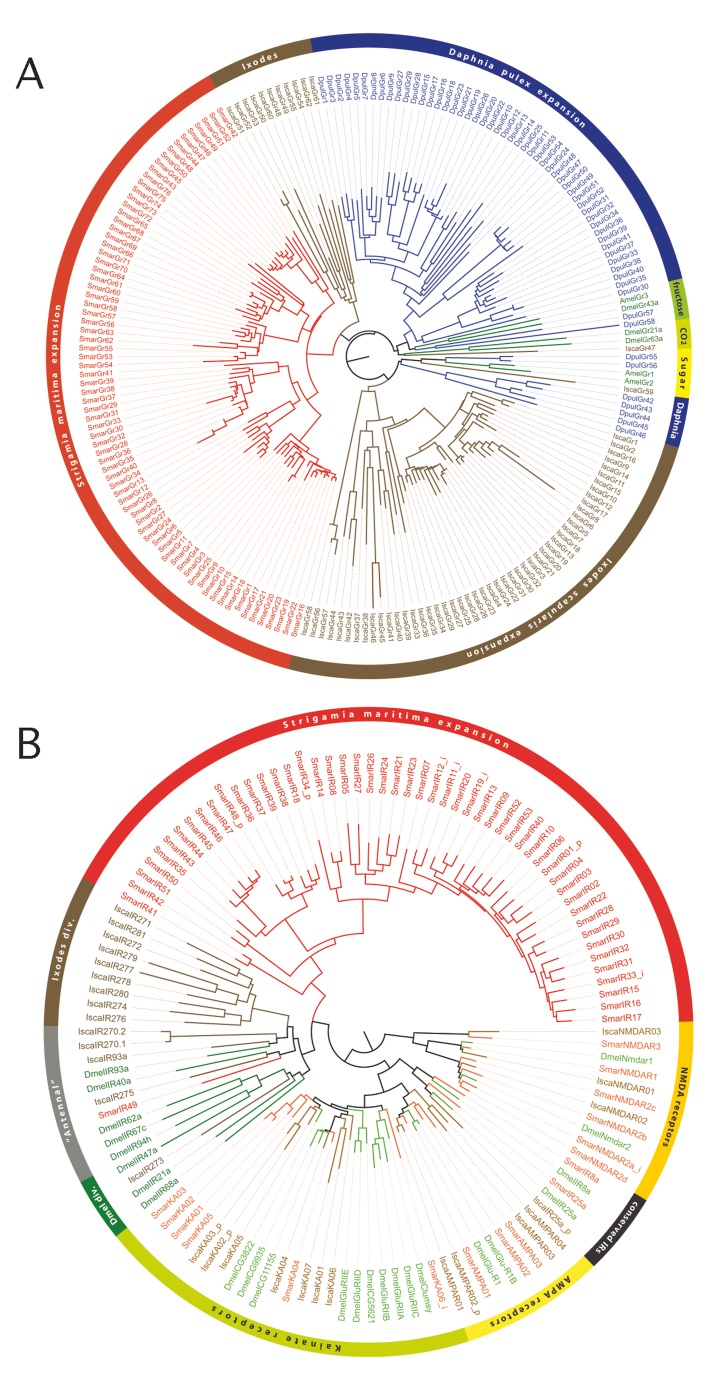
Expansion of chemosensory receptor families.(A) Phylogenetic relationships among S. maritima (Smar), I. scapularis (Isca), D. pulex (Dpul), and a few insect GRs that encode for sugar, fructose, and carbon dioxide receptors (Dmel, D. melanogaster, and Amel, A. mellifera). (B) Phylogenetic relationships among S. maritima, I. scapularis, and a few D. melanogaster IRs and IgluR genes (the suffix at the end of the protein names indicates: i, incomplete and p, pseudogene).